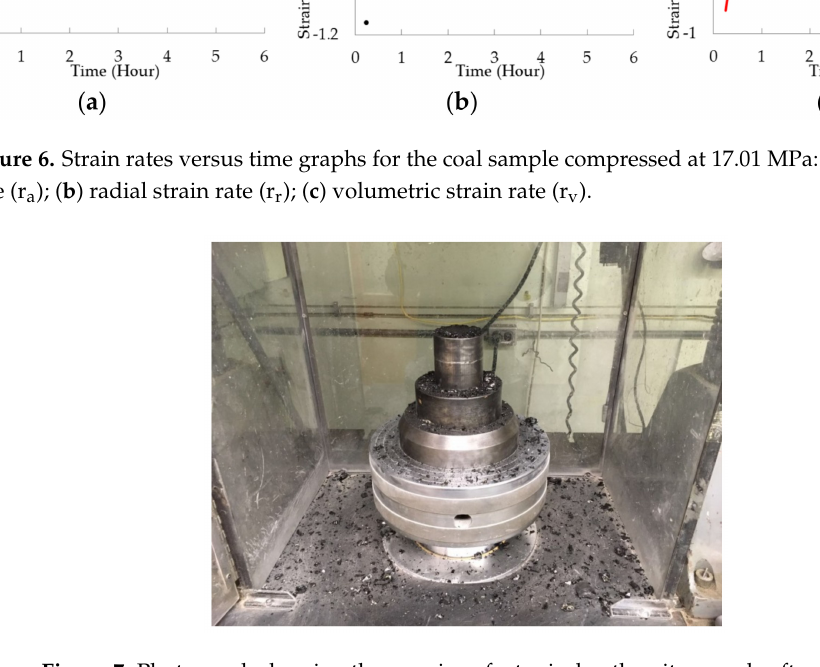
Figure 7. Photograph showing the remains of a typical anthracite sample after failure.